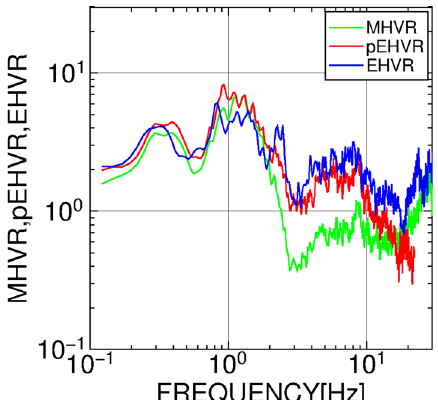
Fig. 4 Comparison of the observed MHVR, the converted pEHVR, and the observed EHVR from aftershock records disclosed after the blind prediction of Step-1 (Table